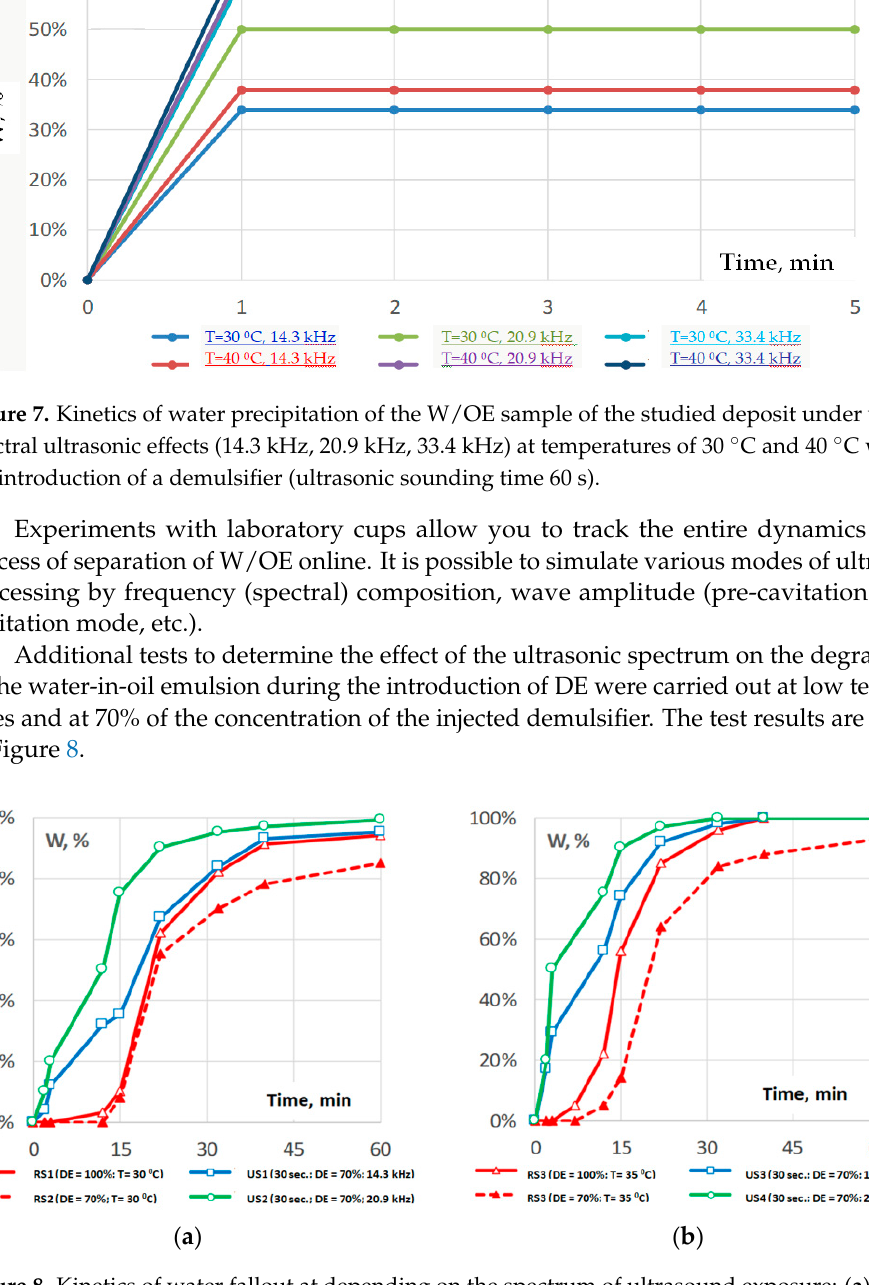
Figure 9. Kinetics of water fallout at a W/OE temperature of 30 ° С depending on the time of ultrasound exposure (W/O = 67%). Analysis of the modes shows that with a duration of 20 s and the DE injection rate = 70% (126 g/ton) from the norm (180 g/ton), fluctuations in the hydrodynamic mode bring the water separation time to an indicator of ~ 100 min. That means this mode is a risk zone. Ultrasonic exposure time should be at least 40 s at a demulsifier injection rate of 70%. In addition, during the experiment, the significant importance of optimizing the hydrodynamic mixing mode during the introduction of a demulsifier was established, since if the water-in-oil emulsion does not move sufficiently, the effectiveness of the demulsifier is sharply reduced. This explains the authors' attempt to identify various